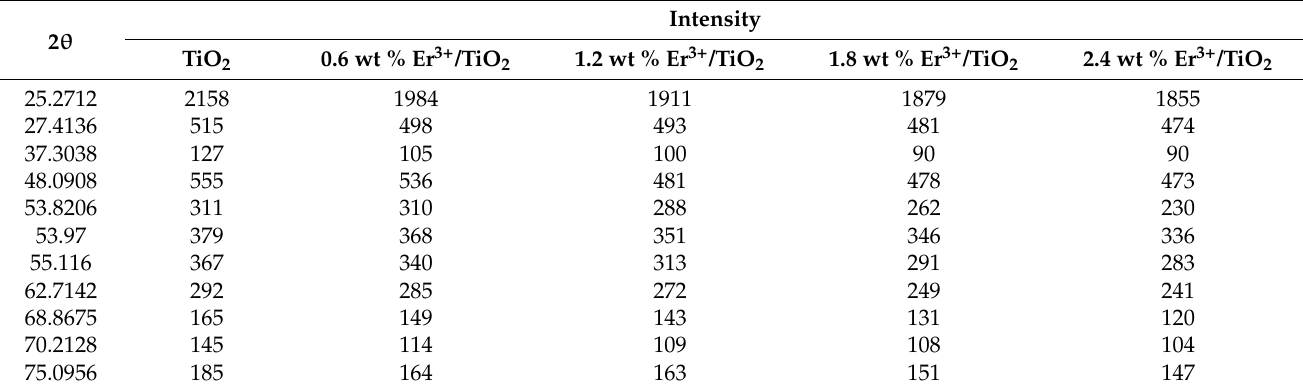
Table 1. Erbium ions/titanium dioxide intensity signals.